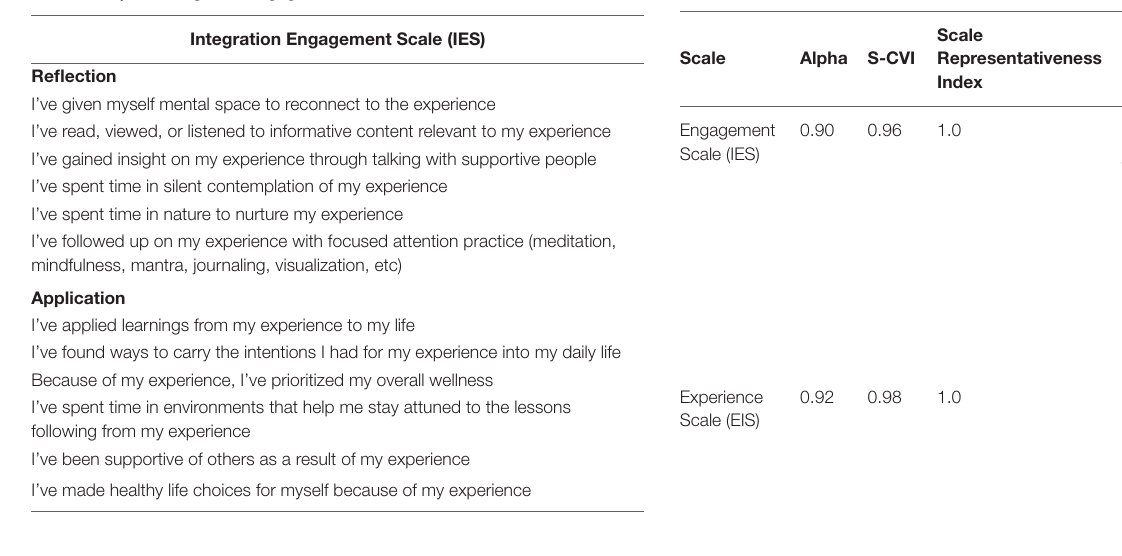
TABLE 12 | The integration engagement scale.